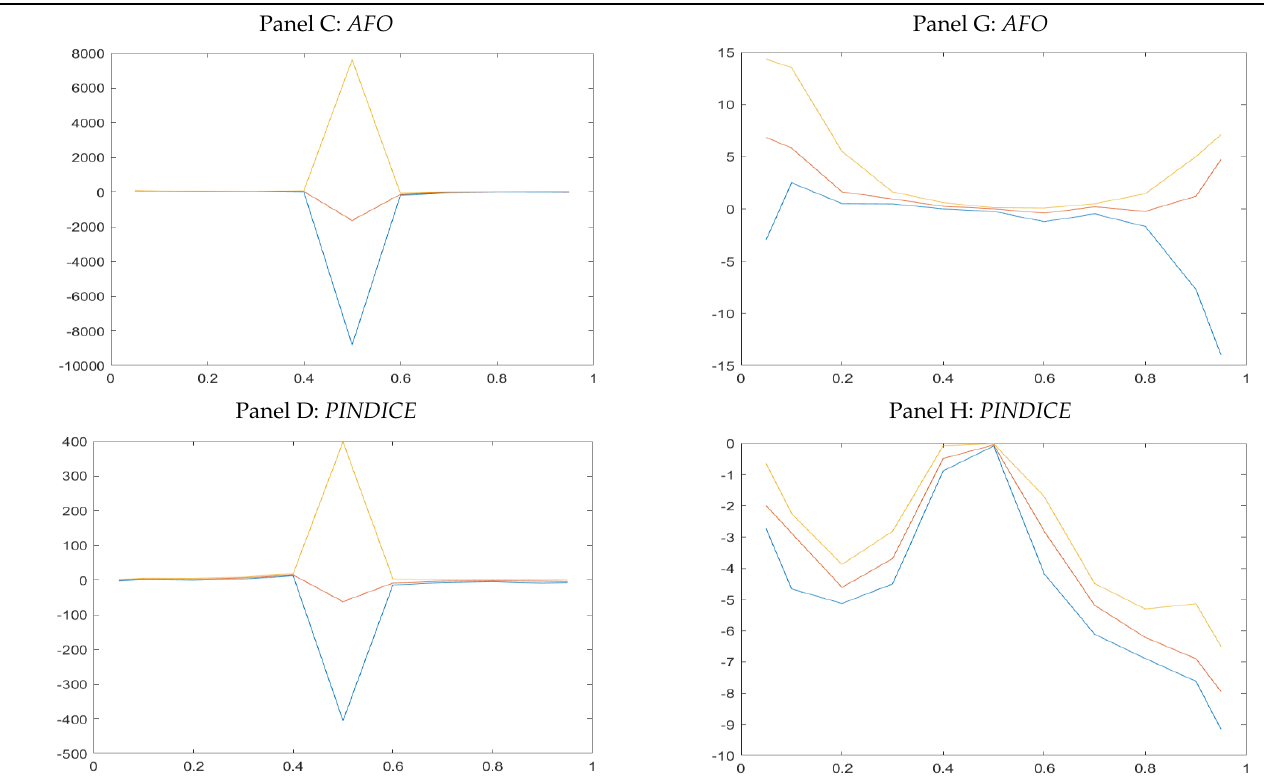
Graphs for Model 3b: ( USDBASD FOREXBV COND ONW PINDICE ) Long-Run Parameters Short-Run